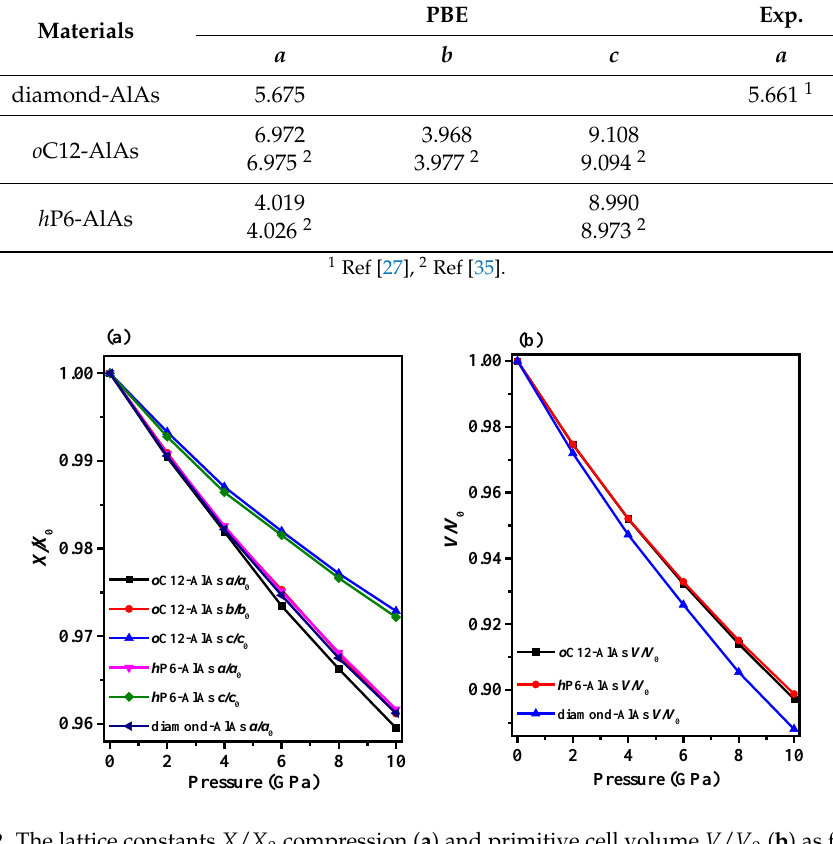
Figure 1. The crystal structures of AlAs in the o C12 phase ( a ) and h P6 phase ( b ). Table 1. The lattice parameters a , b , c (in Å ) of AlAs in the o C12, h P6, and diamond phases . PBE: Perdew–Burke–Ernzerhof.